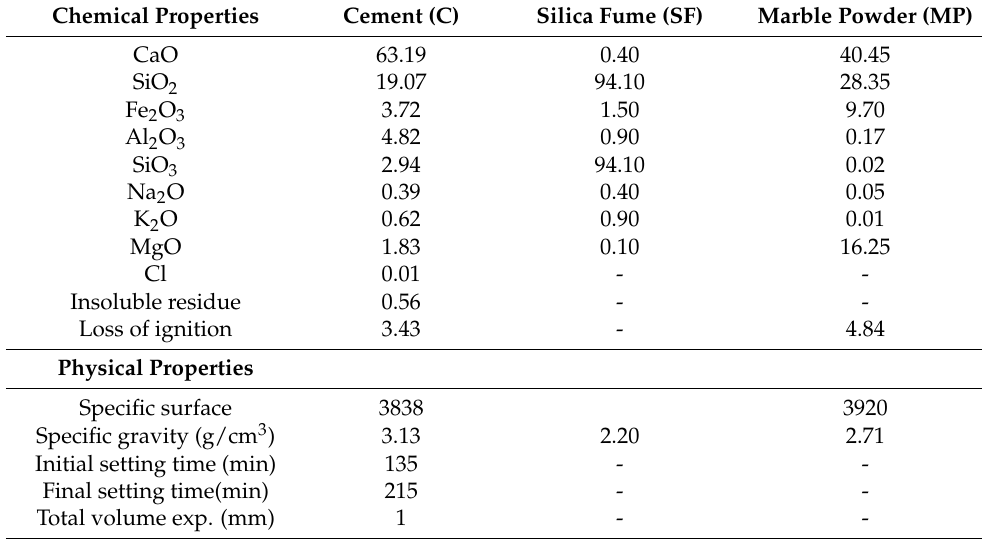
Table 1. Chemical and physical properties of cement, silica fume, and marble powder